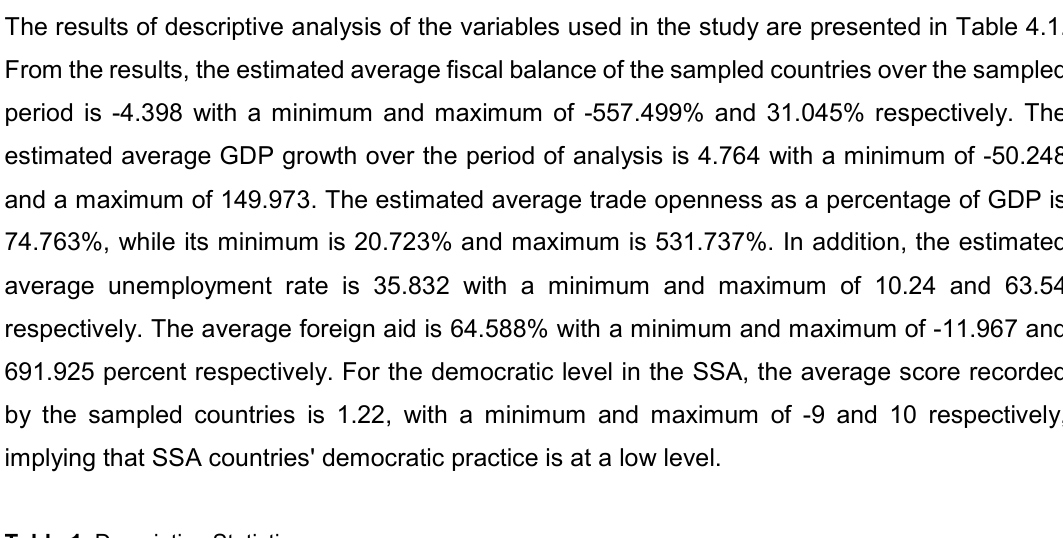
Table 1. Descriptive Statistics.